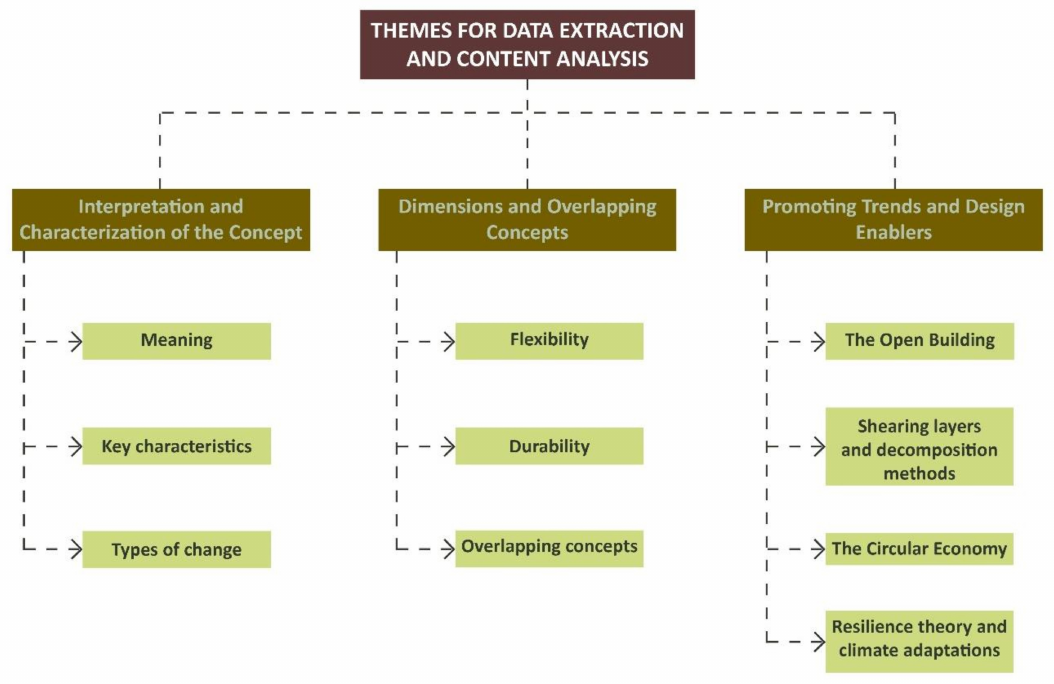
Figure 2. Themes for data extraction and content